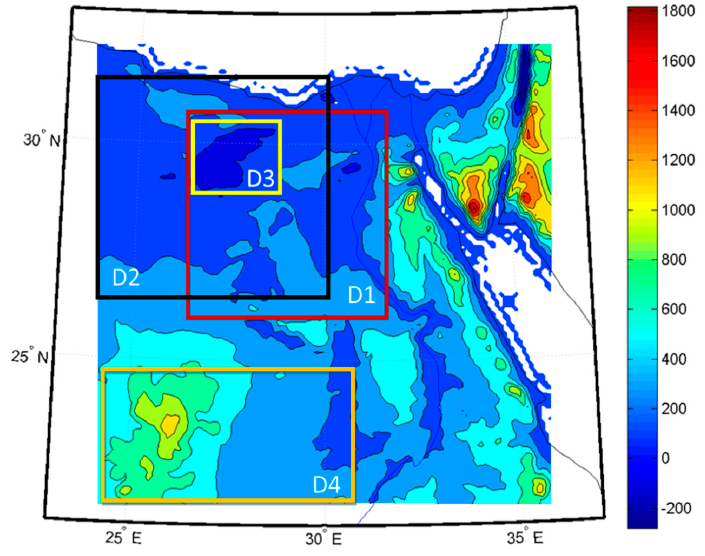
Figure 1. A map of Egypt that includes the configured geographic domain for the WRF model and Terrain height (in m as shown in the color bar). The four sub-domains D1, D2, D3, and D4 are used in the interpretation and validation of the model’s output as explained later in the text.